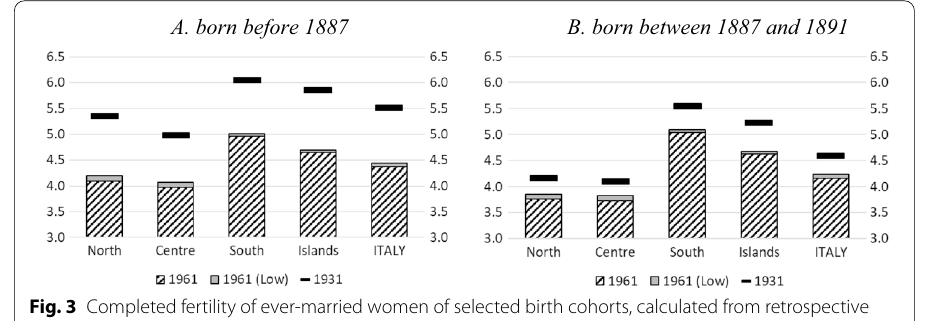
Fig. 3 Completed fertility of ever-married women of selected birth cohorts, calculated from retrospective questions in the surveys of 1931 and 1961; in the latter case also specified for low educated women. Italy. A Born before 1887. B Born between 1887 and 1891. Women born before 1887 ( A ) were observed in 1931 at 45 years and over, and in 1961 at 75 years and over. Women born between 1887 and 1891 ( B ) were observed in 1931 at 40–44 years, and in 1961 at 70–74 years. “Low” means low educated, i.e., with no or, at most, primary education. Source: Istat (1936, 1974) and authors’